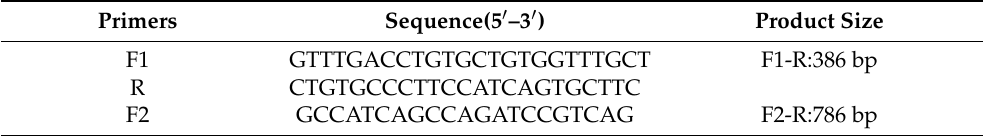
Table 2. Primers are used for multiplex